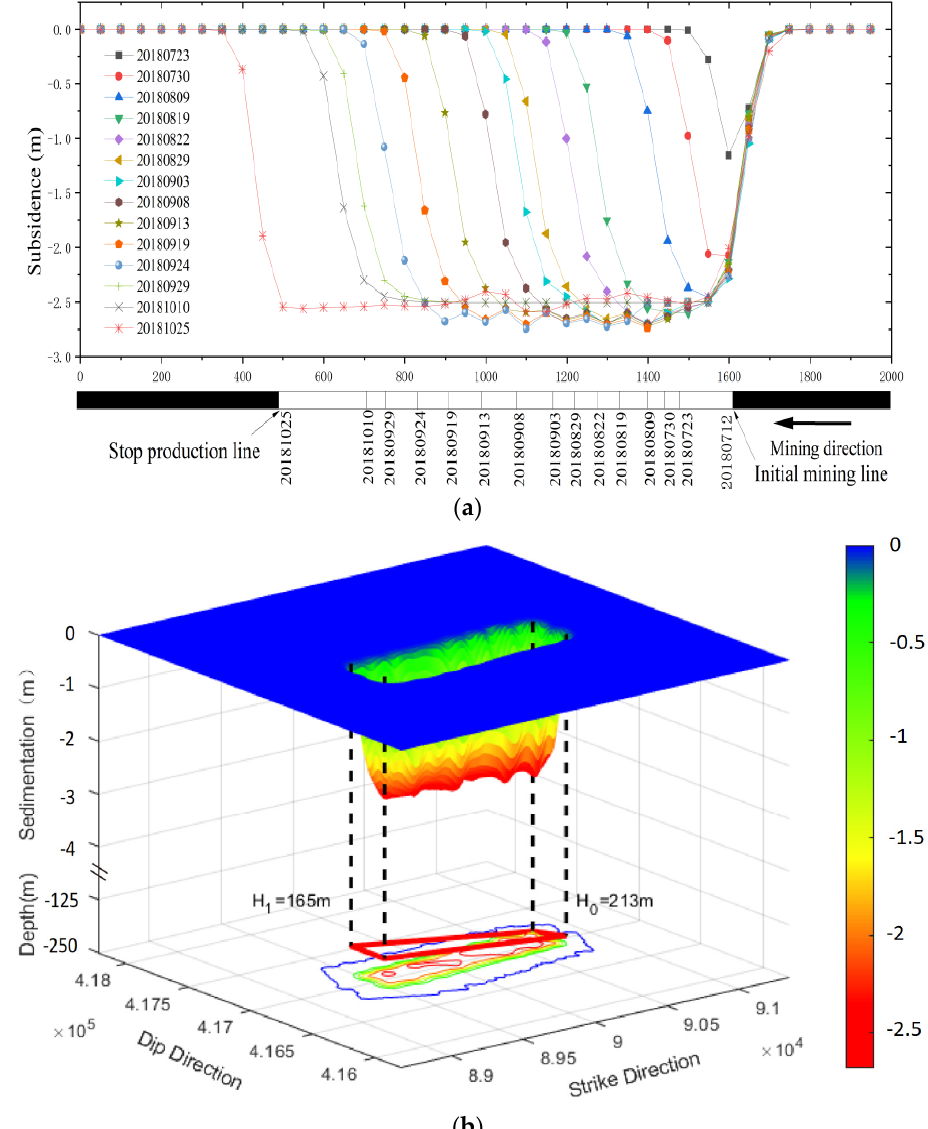
Figure 12. Dynamic cumulative curve of the 2S201 working face, locations of working face during advancement in strike direction, and 3D subsidence map. ( a ) is the time-series cumulative subsidence curve of 2S201 working face; In ( b ), the red box indicates the working face, strike direction means the north, dip direction means the east-west, The corresponding scale is the coordinate value.